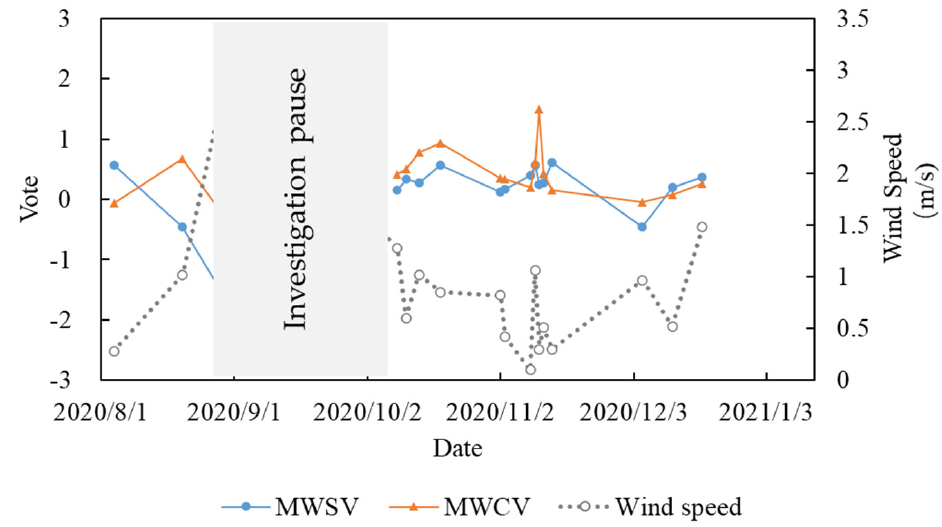
Figure 7. MWSV and MWCV values at the lake side.